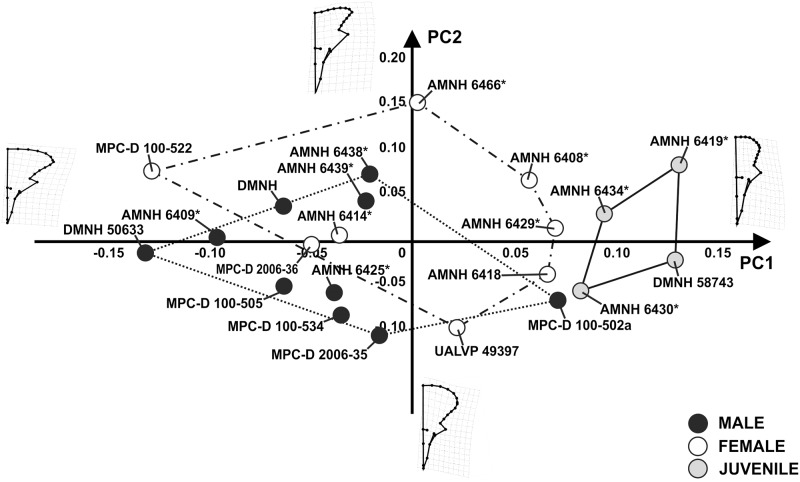
Principal Component Analysis performed on skulls in dorsal view.The continuous line represents “juvenile” morphospace. The dotted line represents “male” morphospace and the dashed line represents “female” morphospace. Asterisks indicate specimens shared with Dodson [25].